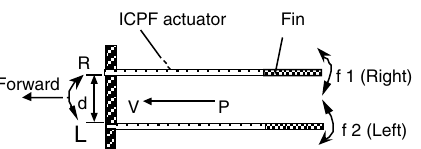
Figure 5 Mechanism of micro-robot using ICPF actuators.